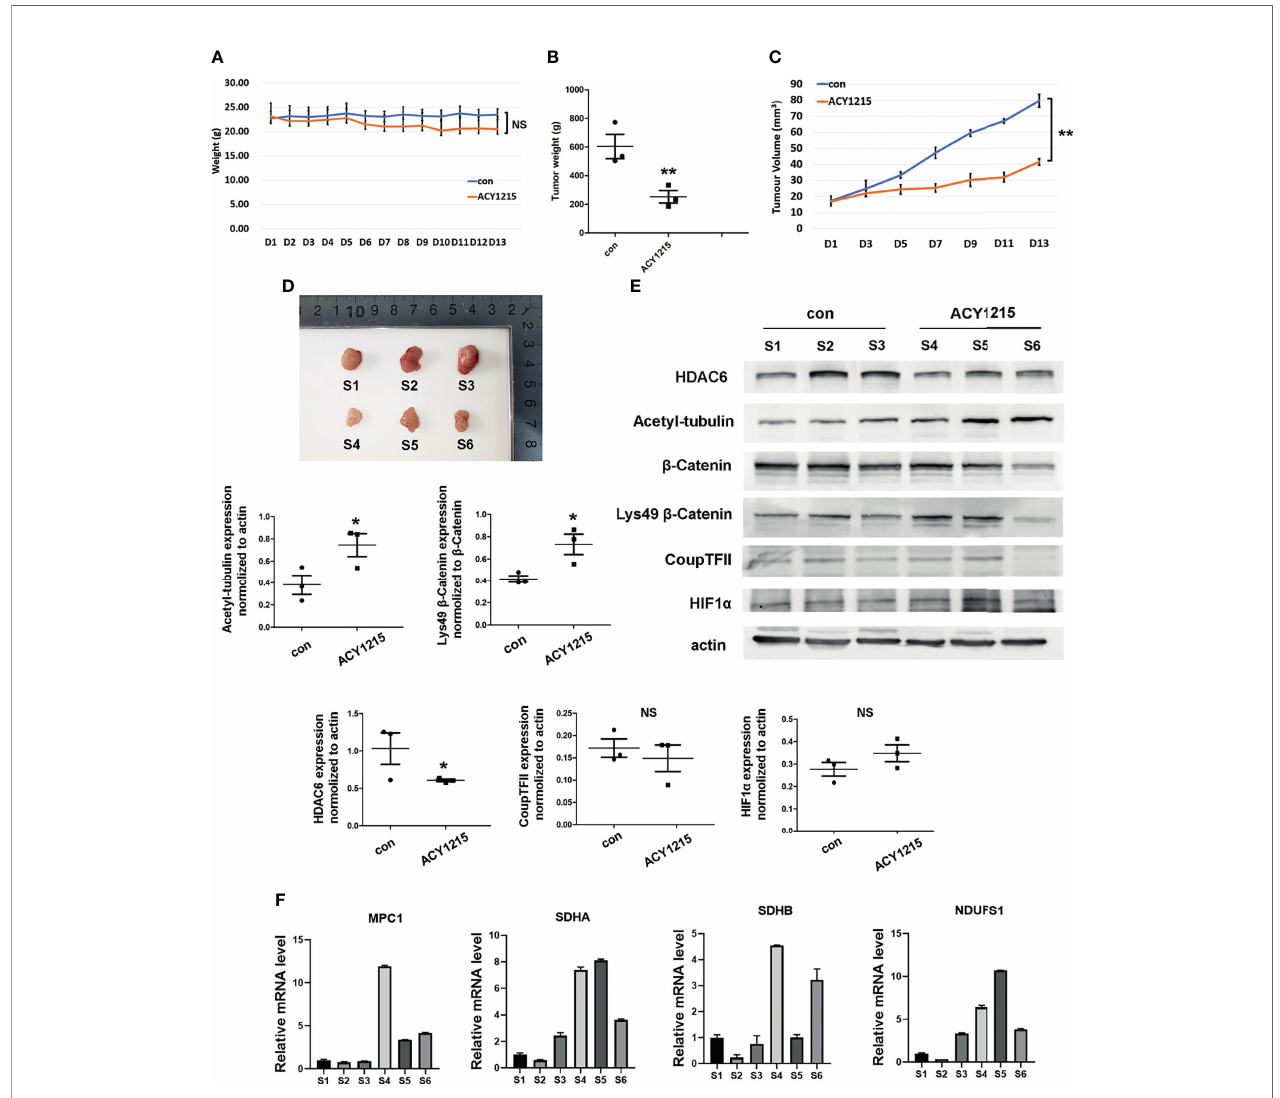
FIGURE 6 | Inhibiting HDAC6/ b -Catenin signal suppressed HCC growth in vivo . (A) Bodyweight was investigated each day. (B) Xenograft tumor weight was recorded on day 13 (means ± SD, n = 3, ** P < 0.01). (C) Tumor volumes was determined by length and width measurement (means ± SD, n = 3, ** P < 0.01). (D) Image of excised tumors from each groups. (E) Tumor tissues from mouse xenograft model were lysed in RIPA and total cell lysates were subjected to western blot analysis. S1-S3 were from control group and S4-S6 were treated with ACY-1215 (means ± SD, n = 3, *P < 0.05; ns, not signi fi cant). (F) Tumor tissues were lysed in TRIzol regent and mRNA level of NDUFS1, SDHA, SDHB and MPC1 were